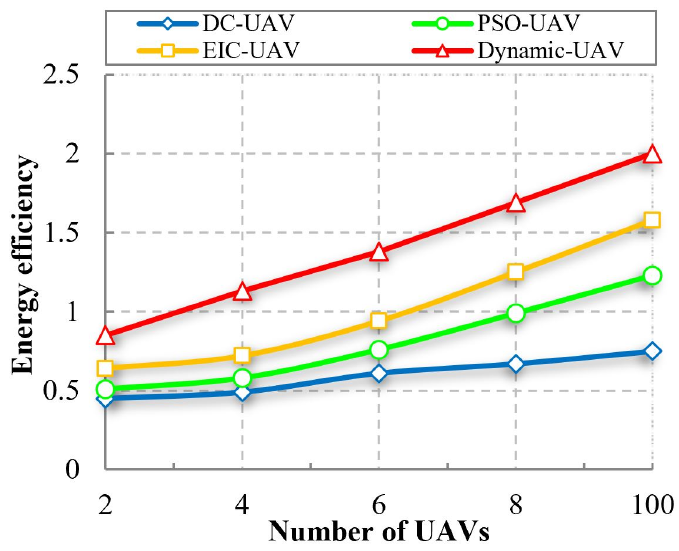
Figure 16. Energy efficiency to Number of UAVs.